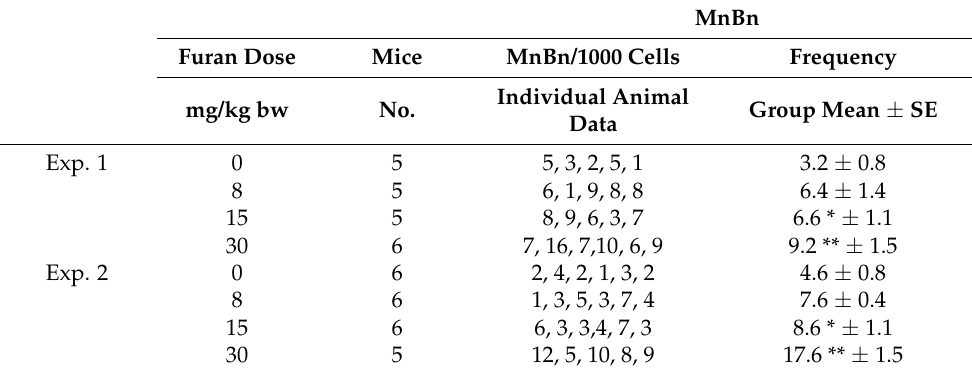
Table 5. Cytogenetic analysis of cytokinesis-blocked splenocytes of C57Bl6 mice following 4-week exposure to furan. MnBn Furan Dose Mice MnBn/1000 Cells Frequency Individual Animal mg/kg bw No. Group Mean ± Data